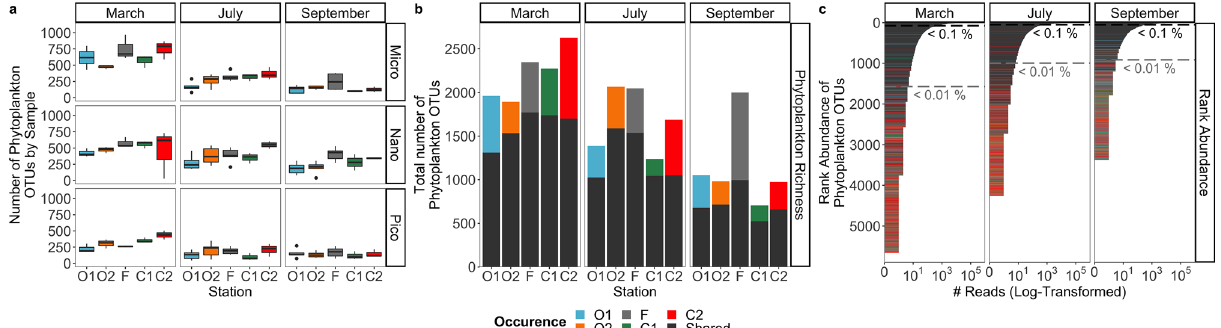
Figure 3. Eukaryotic phytoplankton richness patterns in the Iroise Sea in 2015. ( a ) Variability of phytoplankton richness (# of OTUs by samples) across our 184 samples. The figure represents the variability of phytoplankton richness (y-axis) across stations (x-axis), size-fractions (right panels) and seasons (top panels). The variability in these sections is represented by samples triplicated and sampled across two depths (when carried out). ( b ) Total merged phytoplankton richness over our 5 stations and 3 seasons (size of barplots, 15 samples). The color code in each barplot represents two categories of occurrence, the OTUs that are ‘shared’ (in dark gray) by at least two stations in a same season, and the OTUs ‘specific to station X’ within a season (see the respective colors in the legend). This color legend is shared with ( c ). ( c ) Rank abundance curves of all eukaryotic phytoplankton OTUs found in each season. Each OTU is represented by a bar in the graphic, the color of the bar corresponds to the same categories of occurrence as ( b ). The number of reads of OTUs was log-transformed for the sake of presentation. The dotted lines separate OTUs across abundance thresholds, the abundant OTUs (> 0.1% of the total read number of phytoplankton OTUs by season), the low abundant OTUs (0.1–0.01%) and the rare OTUs (<